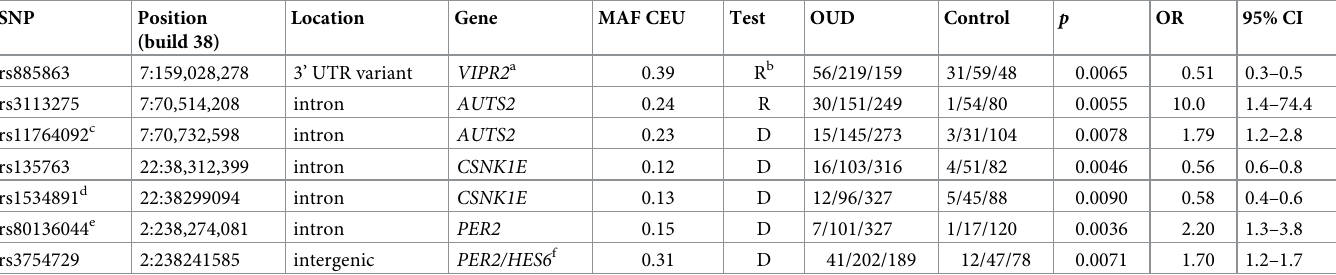
Table 2. Top association signals ( p <